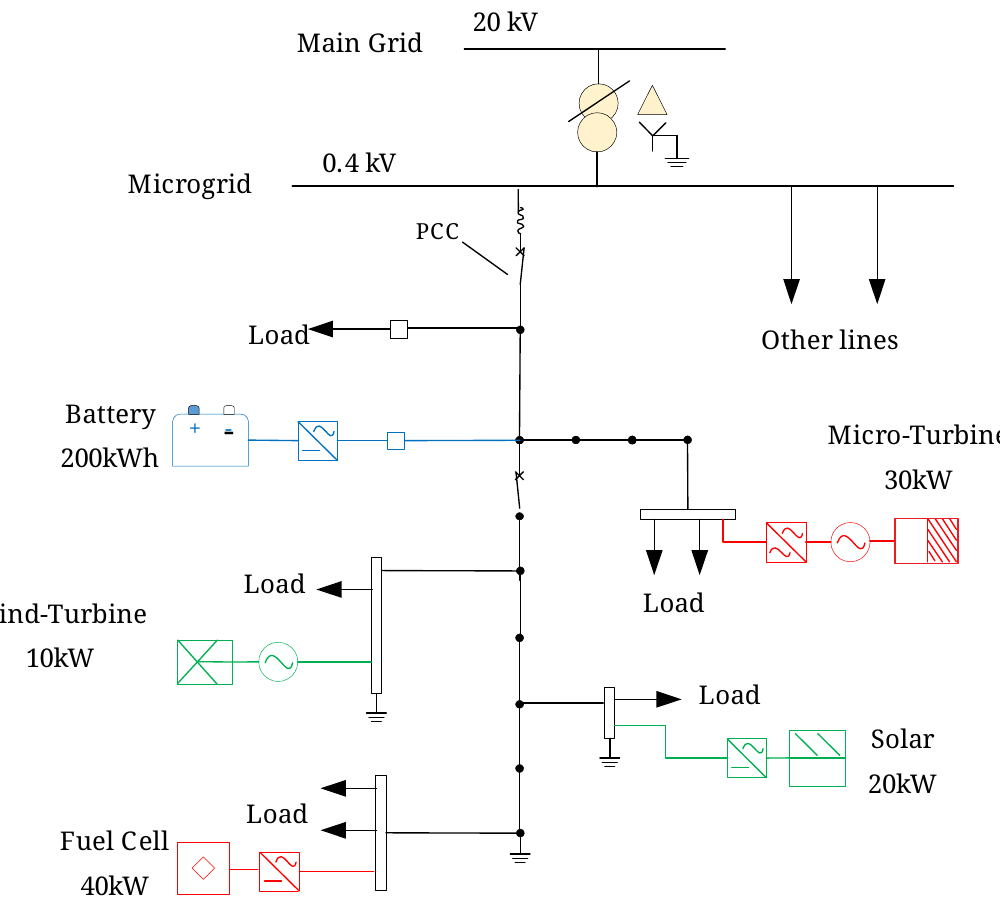
Figure 2. Architecture of the European benchmark low voltage MG system. The MG consists of a 30 kW MT, a 30 kW FC, a 20 kW solar PVs system, a 10 kW WT and a capacity of 200 kWh ESS, and loads. The maximum power limit of the MG at PCC is 200